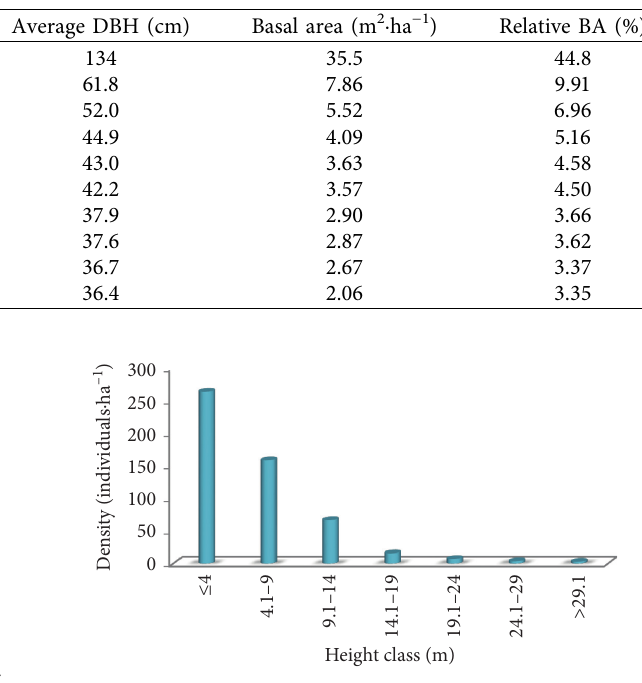
Figure 8: Height class distribution of woody species in Kafta Sheraro National